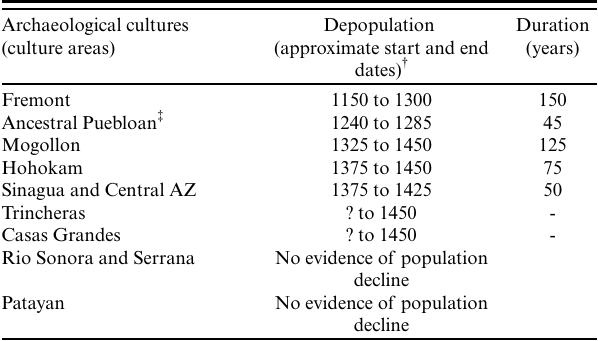
Table 1 . Depopulation dates and the speed (duration) of depopulation by culture